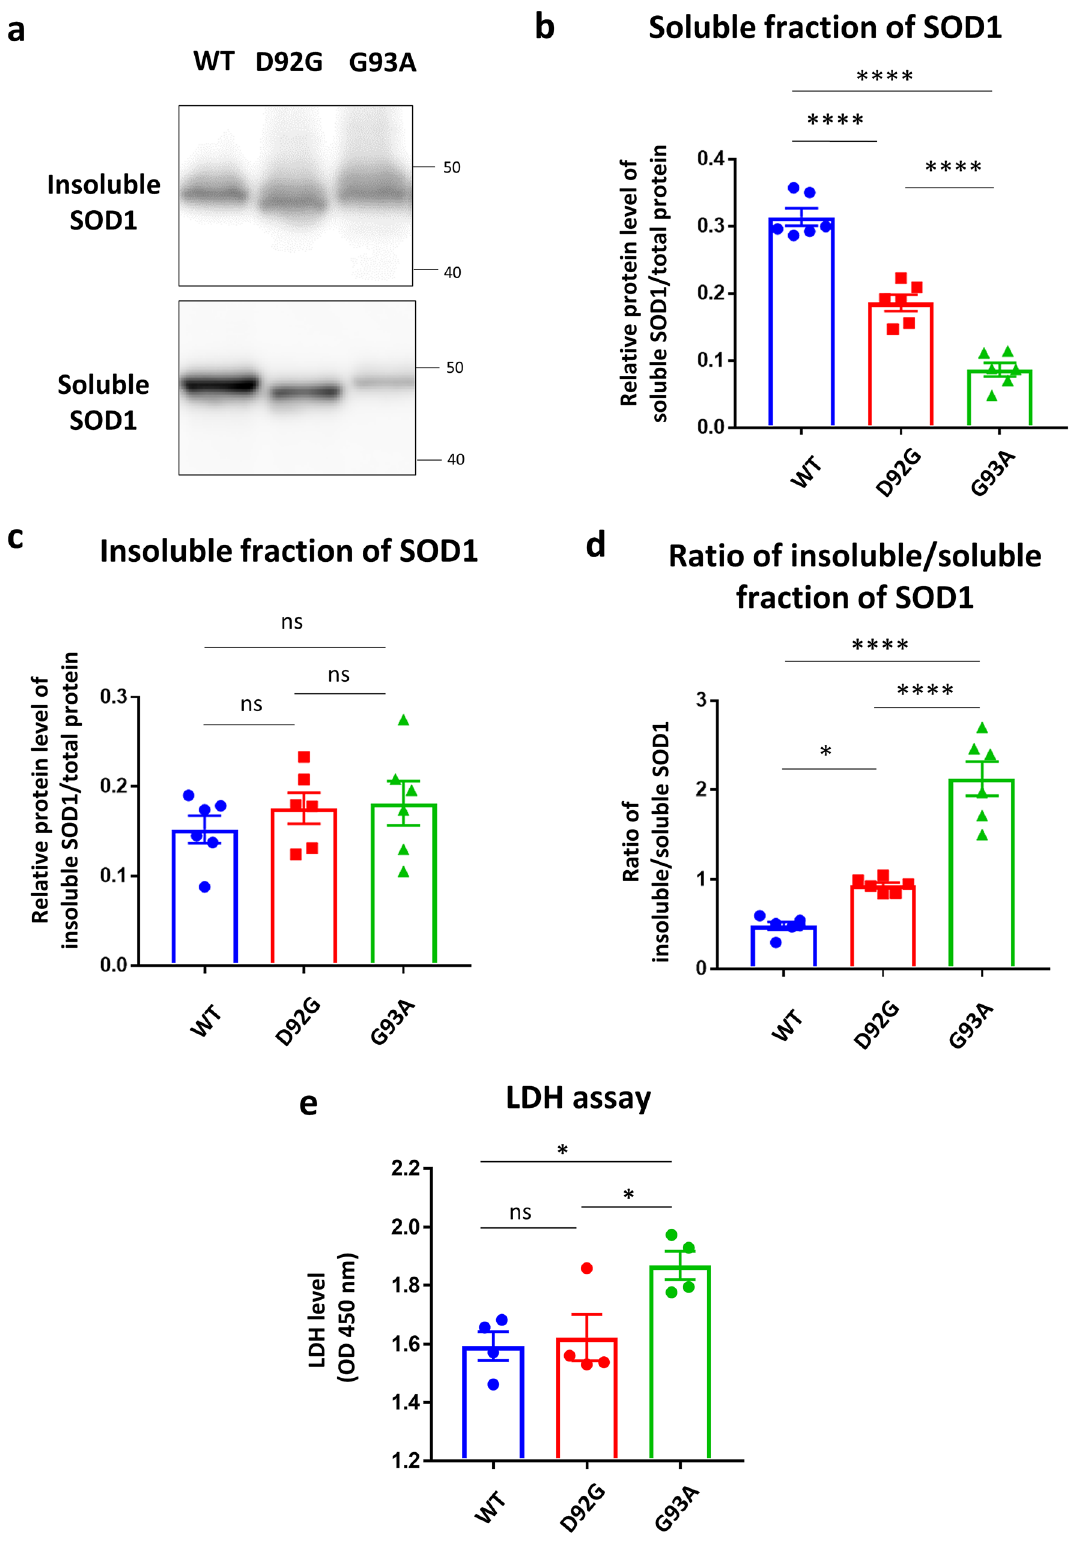
Figure 3. Western blotting analysis of mutant SOD1. ( a ) Representative western blotting images of SOD1 in soluble and insoluble fractions of cells expressing SOD1-WT, D92G, and G93A. Two panels were cropped from original blots presented by Supplementary Fig. 2. (b , c ) Quantitative analysis of SOD1 in the soluble fraction ( b ) and insoluble fraction ( c ) of cells expressing SOD1-WT, D92G, and G93A (n = 6). ( d ) The ratio of insoluble/soluble fraction of SOD1 of cells expressing SOD1-WT, D92G, and G93A. ( e ) Cellular toxicity level in SOD1-WT, D92G, and G93A was determined by LDH (n = 4). Data are shown as means ± SD. One-way ANOVA (followed by Tukey’s test) was used for statistical analysis. *p < 0.05, ****p < 0.0001. OD optical